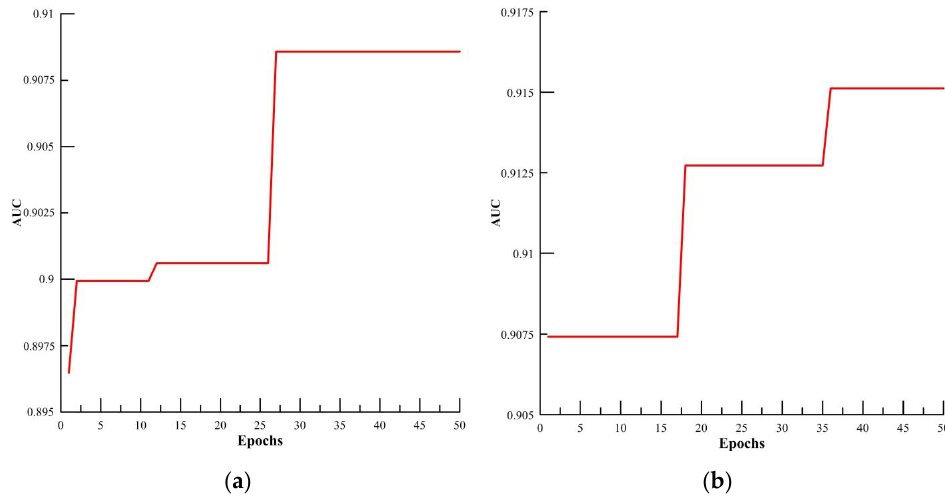
Figure 10. Curves of area under curve (AUC) value: ( a ) bat algorithm multilayer perceptron (BA-MLP); ( b ) firefly algorithm multilayer perceptron (FA-MLP).